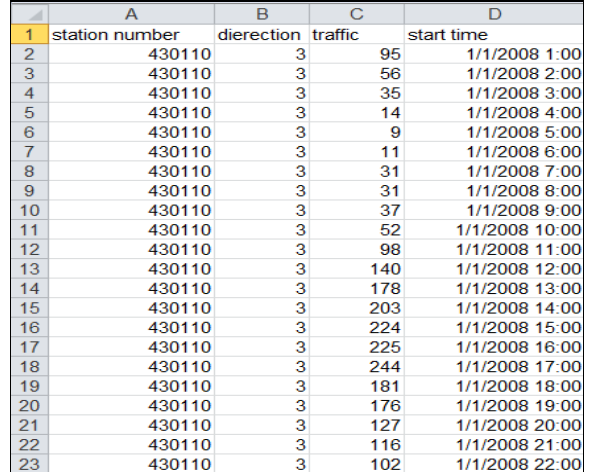
Figure 5 .Format of the traffic data